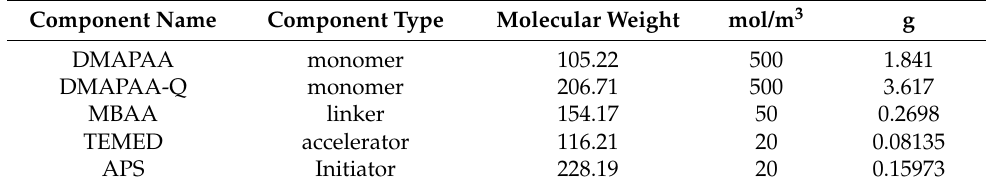
Table 3. Synthesis condition of the AQ11